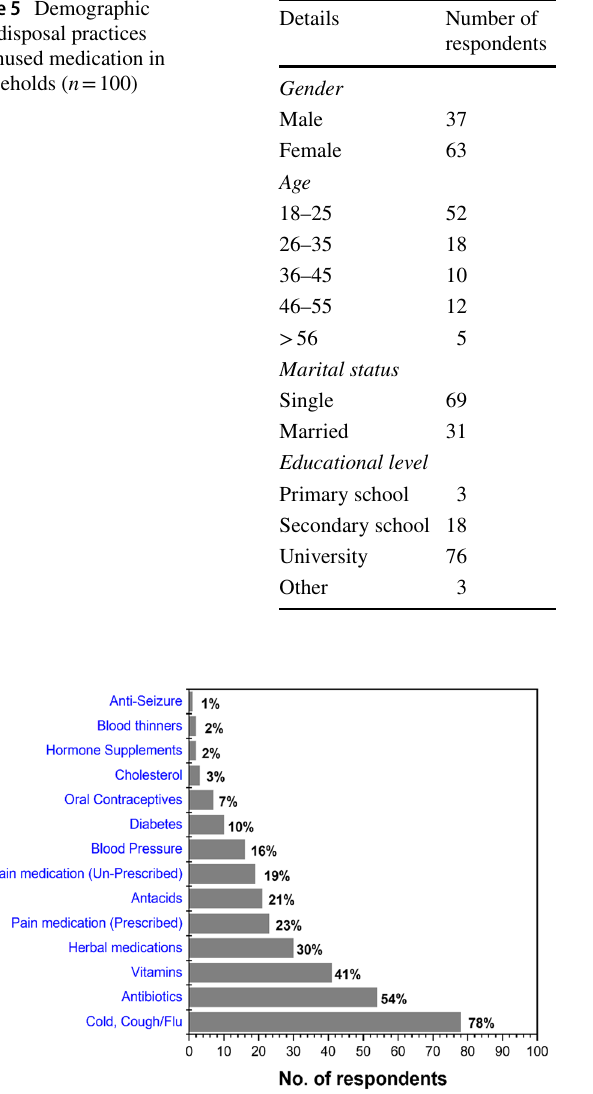
Fig. 4 Different types of medications that were stored in households ( n = 100)